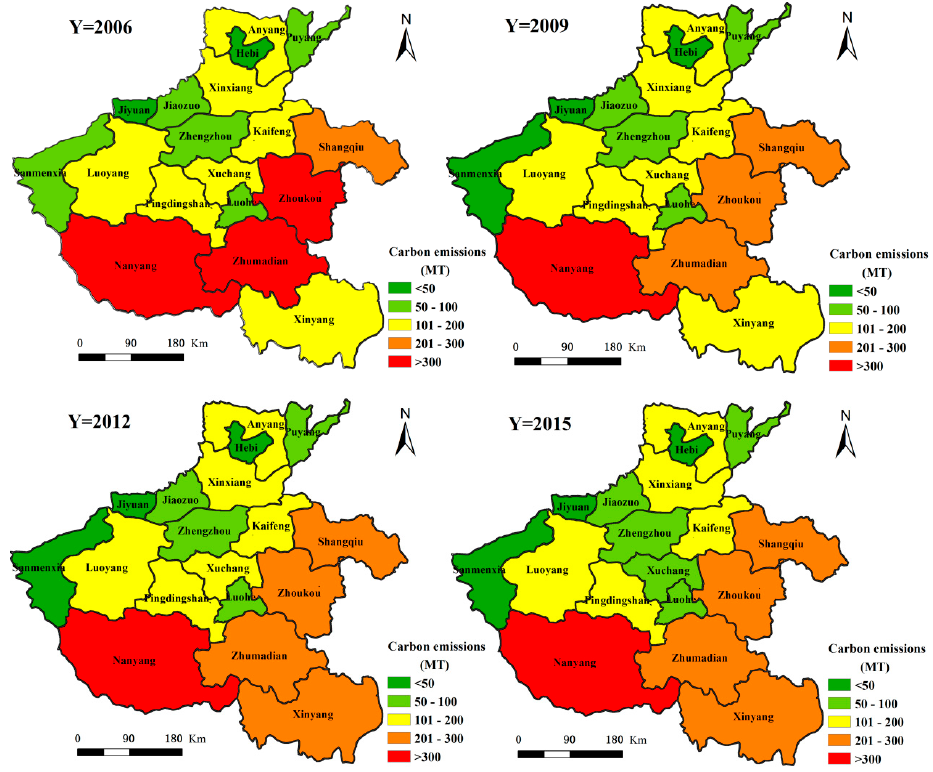
Figure 4. Spatial differences in carbon emissions from the primary sector in Henan Province during 2006–2015.